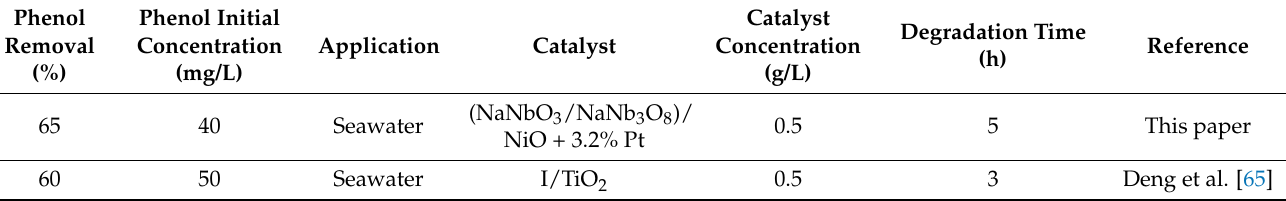
Table 3. Comparative data on phenol removal reported in other